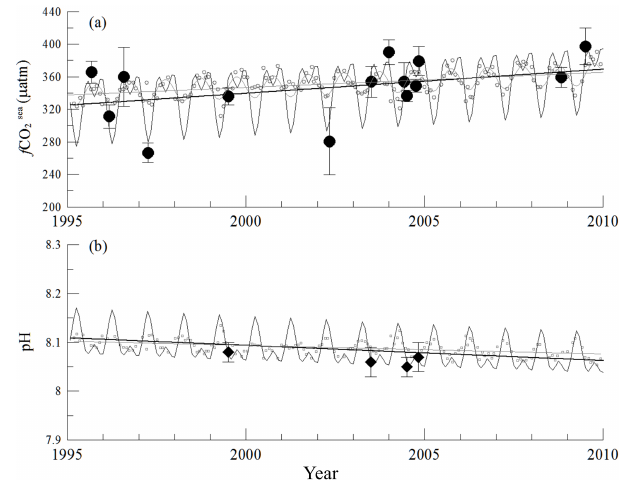
Fig. 7. Secular variation of (a) f CO 2 (µatm) (black filled circles and fitting line), and (b) pH (black diamonds and fitting line) of the surface water in the UB. The time-series p CO 2 (µatm) (gray open circles) and pH (gray open squares) at Station ALOHA in the subtropical North Pacific Ocean are also shown for comparison. The p CO 2 and pH data at Station ALOHA are from D. Karl, Uni- versity of Hawaii (http://hahana.soest.hawaii.edu) and are updated from Doney et al. (2009) and Dore et al.